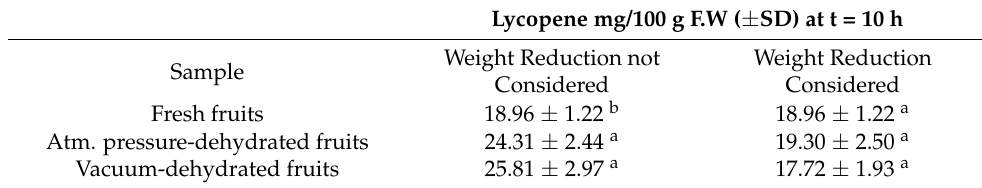
Table 3. Lycopene retention after 10 h of osmotic treatment of autumn olive fruits.